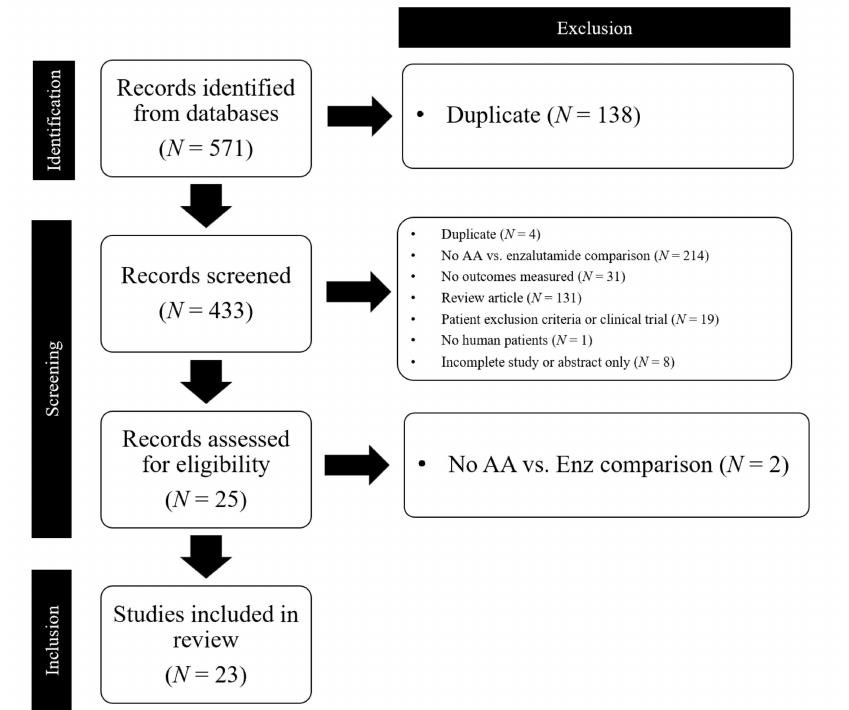
Figure 1. PRISMA Flow Chart of studies included in the scoping review. AA = abiraterone acetate; Enz =